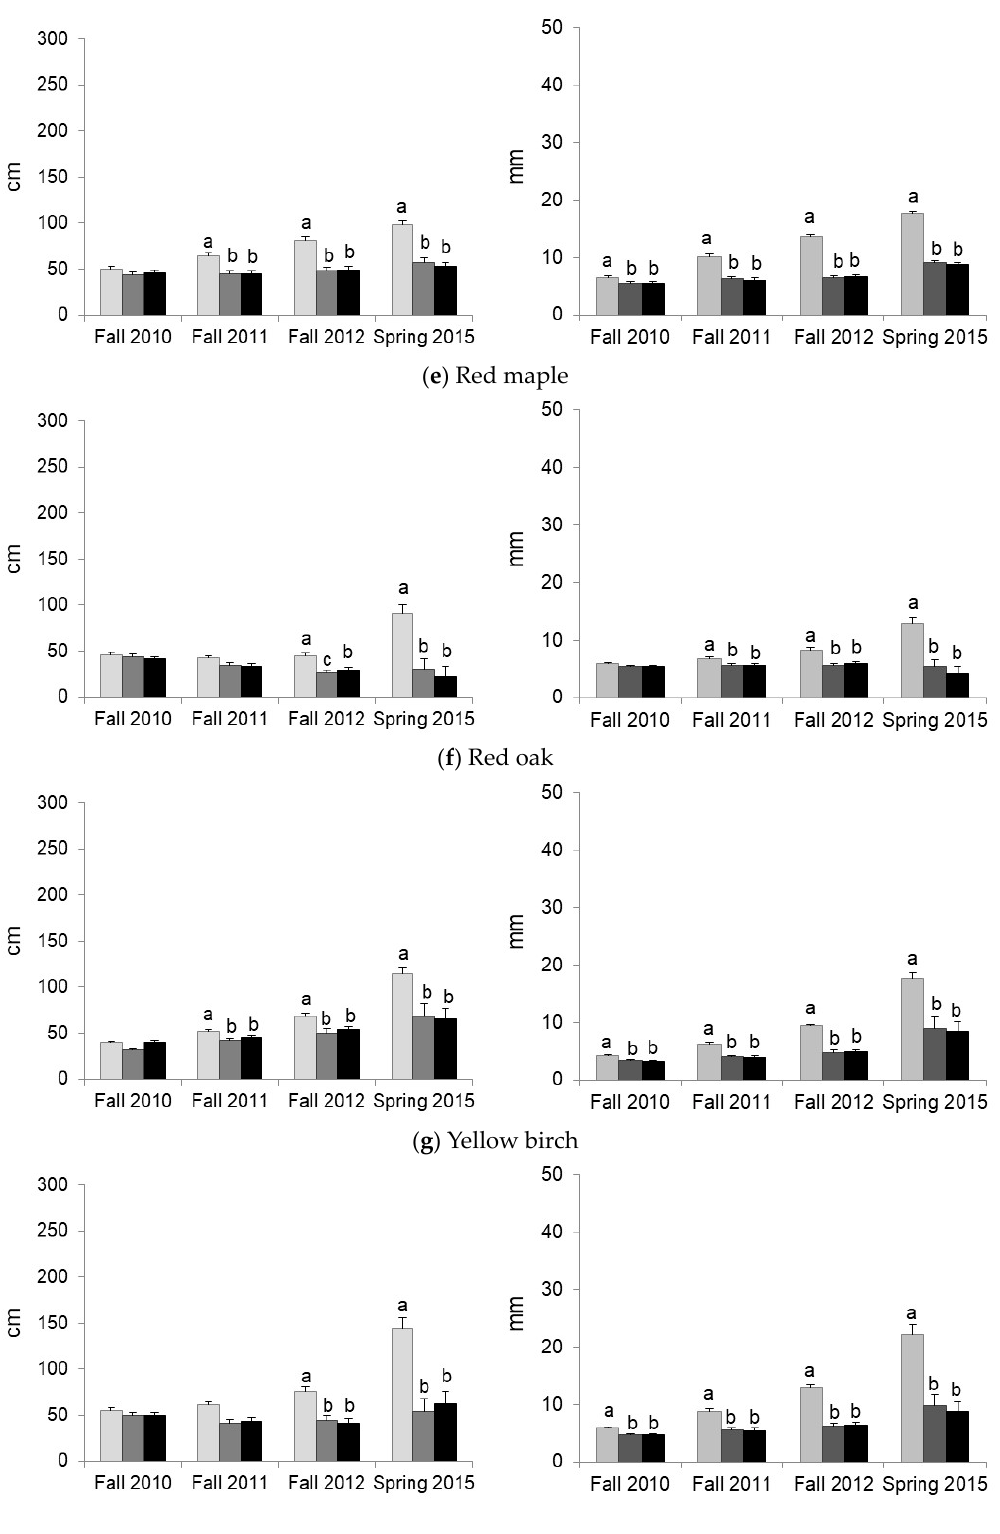
Figure 2. Height and diameter of seedlings (least-squares means and SE) growing in bare soil subplots (BS; light grey), surrounded by mulch mat (M; medium grey) or in vegetation subplots (VG; black), from autumn 2010 − 2012 and in spring 2015.